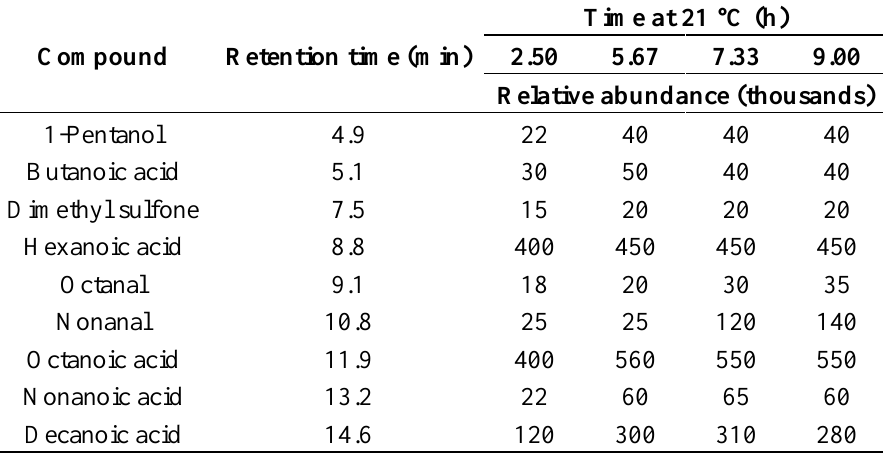
Table 3. Relative abundance of volatile compounds in milk and variations with equilibration